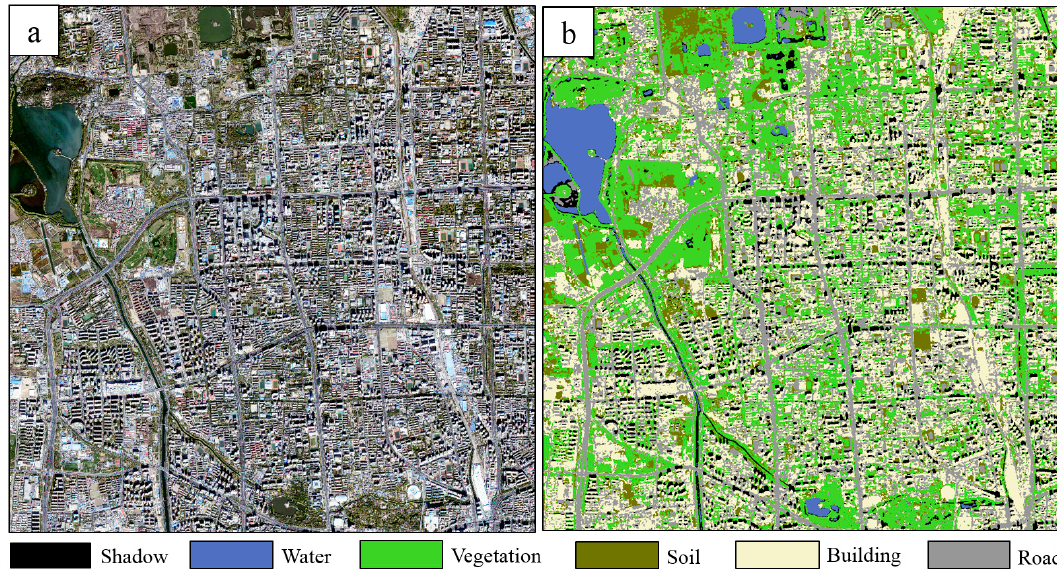
Figure 10. The study area in Beijing, China: ( a ) a WorldView-II image (in band combination 5/3/2, true color) and main road lines are used to generate functional zones; and ( b ) points-of-interest (POIs) are used to evaluate segmentation results.